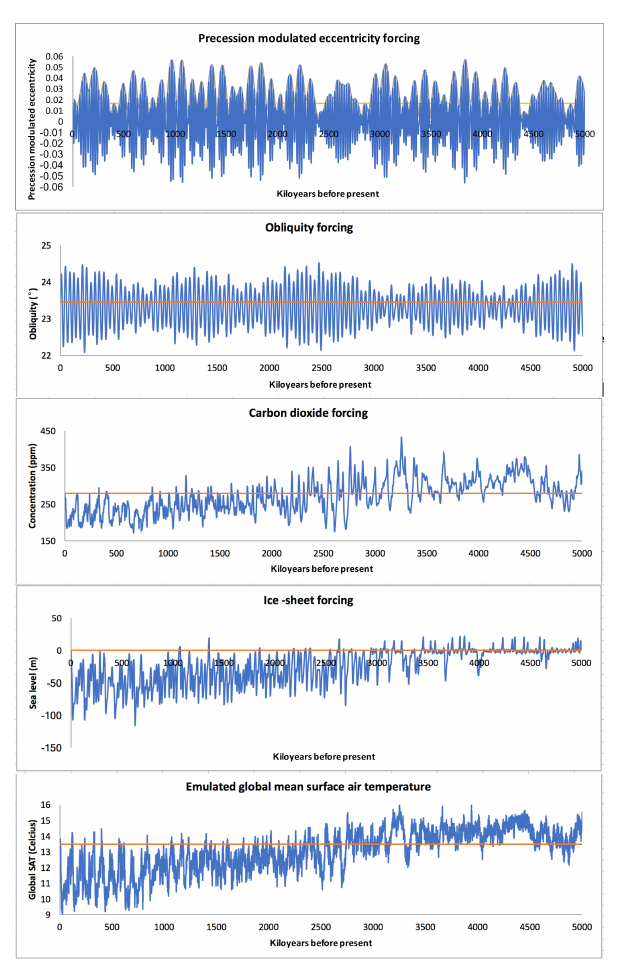
Figure 2. Emulator time-series forcing and reconstructed global surface air temperature. Orbital forcing is Berger and Loutre (1991, 1999). Ice-sheet forcing is the sea-level reconstruction of Stap et al. (2017). Carbon dioxide forcing after 800000BP is ice core data (Luethi et al., 2008), using the Stap et al. (2017) reconstruction in the earlier